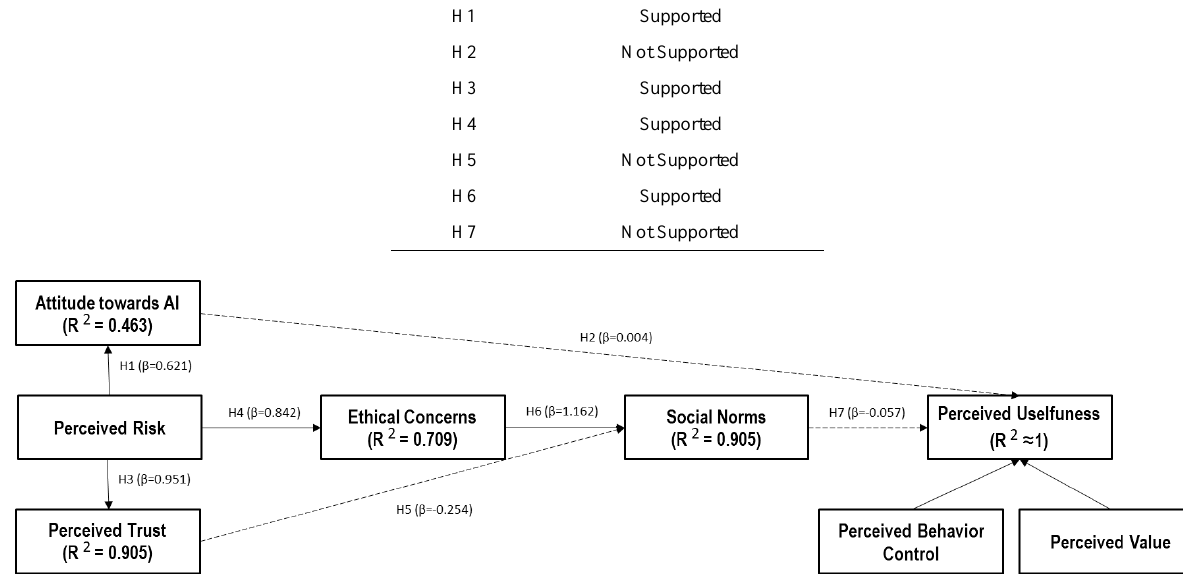
Figure 3. Results of Structural Equation Modelling (non-significant paths in dashed